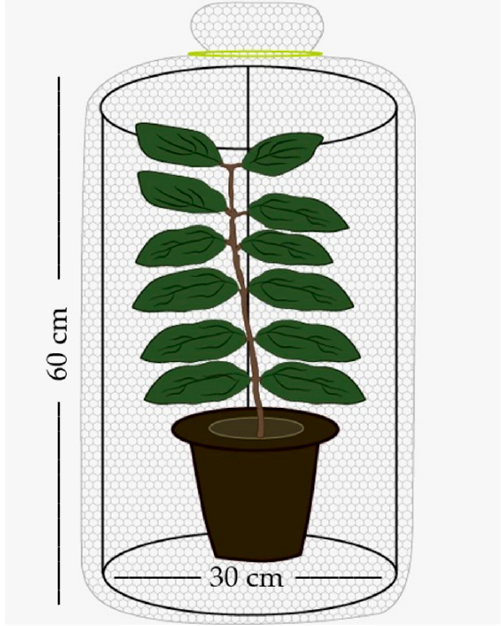
Figure 1. Drawing of cylindrical cage with a coffee seedling.